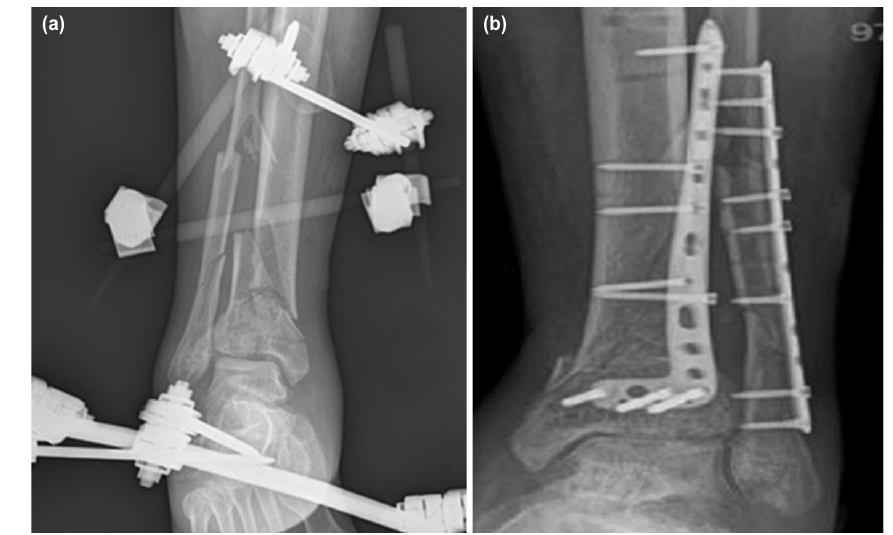
(a) Radiograph images of the patient who did not have fibula fixation in the first stage. In the first stage, only external fixator Fig. 2: was applied for fractures of the tibia and fibula. (b) Definitive treatment was applied to the fracture of the tibia and fibula after soft tissue swelling